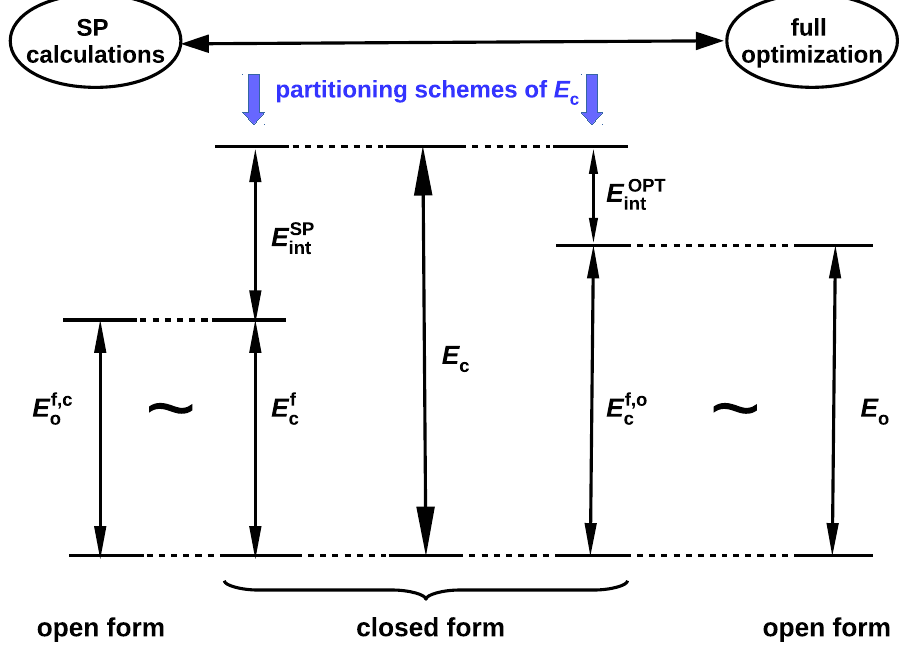
Figure 2. Scheme showing two variants of the closed form total energy partition ( E c ) to the interaction energy ( E int ) and the total energy of the fictitious closed form ( E f c ) obtained after ‘excluding’ this